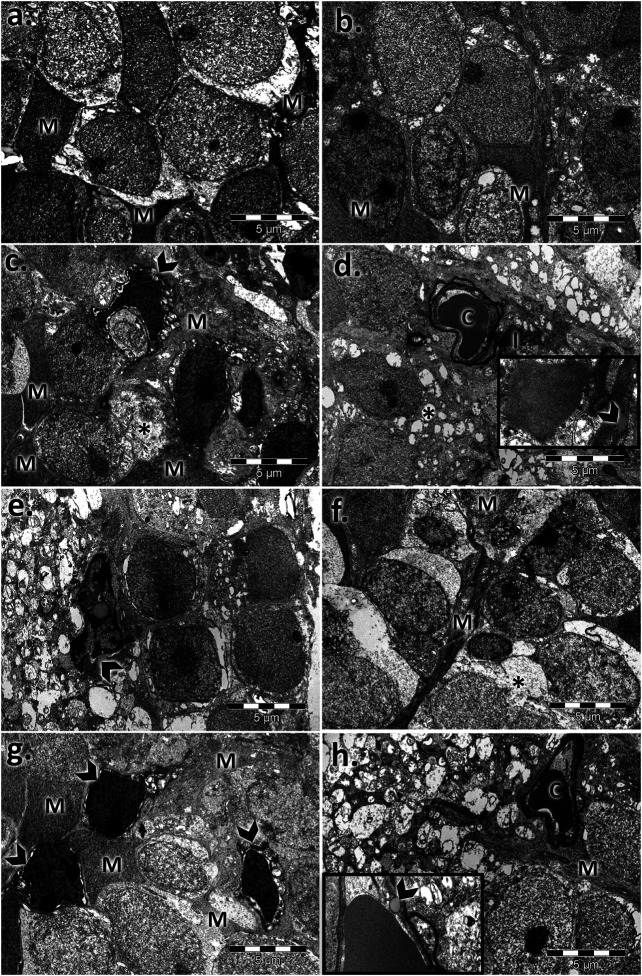
Electron micrographs showing the ultrastructural features of the inner nuclear layer (INL) of the young and aged retinas. (A) control male; (B) control female; (C,F) aged male retina—hypertrophied Müller cells (M), condensed Müller cell nuclei (arrowhead), bipolar cells (B), and capillaries (C) with a thickened basement membrane and lipids (l); empty spaces (*); detail: lipid accumulation beside the capillary and into the basal membrane (arrowhead); damaged INL areas in the aged male retina with microglia (arrowhead) (G,H) aged female retina—hypertrophied Müller cells (M); condensed Müller cells nuclei (arrowhead), capillary with thickened basement membrane (C); bipolar cells (B); detail: lipid accumulation beside the capillaries and into the basal membrane (arrowhead). Figures are representative of n = 10 electron micrographs for each individual/group.